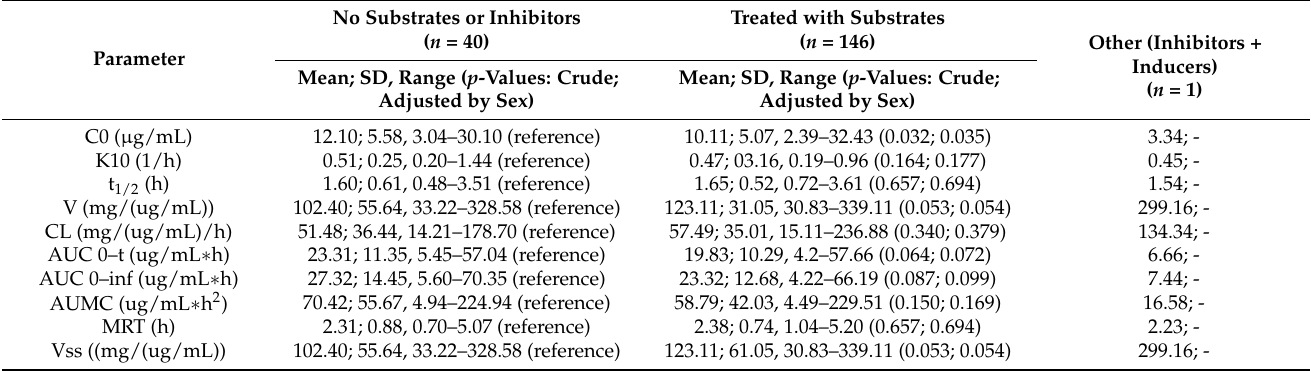
Table 5. Acetaminophen pharmacokinetics according to drug therapy concomitant to